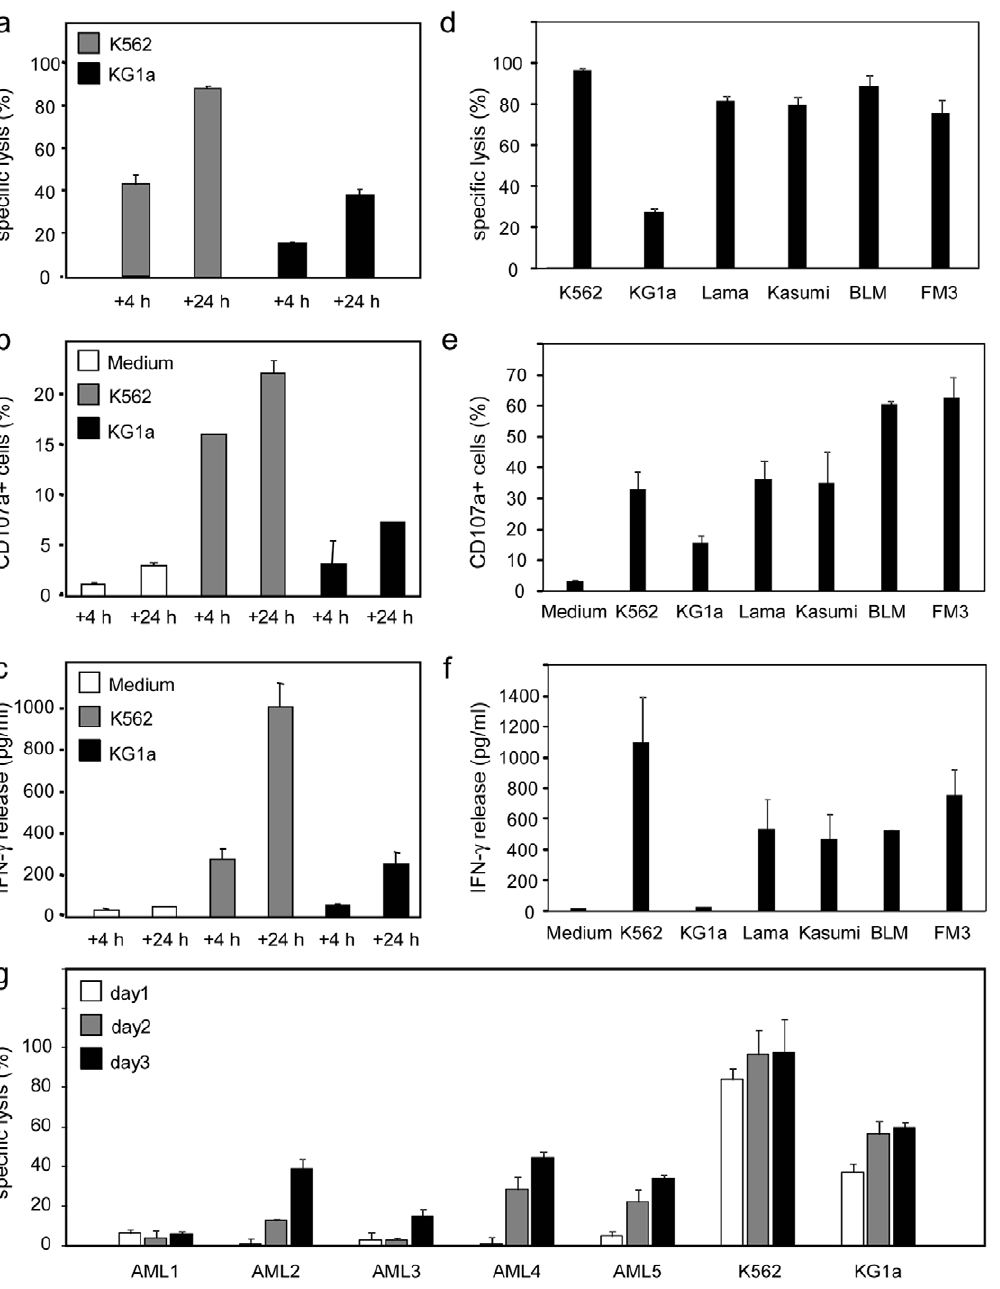
Figure 6. Functional activity of exvivo -generated CD56 + NK cells using Method II with GBGM. ( a ) Specific cytotoxicity of a CD56 + NK cell product (98% purity) against the myeloid leukemia cell lines K562 and KG1a. Specific lysis was determined after 4 and 24 hours of co-culture in a FCM-based cytotoxicity assay at an E:T ratio of 2:1. Data are displayed as mean 6 SD of triplicate wells. ( b ) Degranulation of CD56 + NK cells was determined by FCM as the percentage of CD107a + cells. Results are depicted as mean 6 SD of triplicate wells. ( c ) IFN c production was determined by ELISA and depicted as mean 6 SD of triplicate measurements. ( d ) Specific cytotoxicity of another CD56 + NK cell product (95% purity) against the myeloid leukemia cell lines K562, Lama, Kasumi and KG1a, and the melanoma cell lines BLM and FM3. Specific lysis was determined after 18 hours of co-culture in a FCM-based cytotoxicity assay at an E:T ratio of 1:1. Data are displayed as mean 6 SD of triplicate samples. ( e ) Degranulation of CD56 + NK cells was determined by FCM as the percentage of CD107a + cells after overnight stimulation with different targets. Data are depicted as mean 6 SD of triplicate samples. ( f ) IFN c production was determined by ELISA and depicted as mean 6 SD of triplicate measurements. ( g ) Specific cytotoxicity of a third CD56 + NK cell product (97% purity) against primary AML cells from 5 different patients. Specific lysis was determined after 24, 48 and 72 hours of co-culture in a FCM-based cytotoxicity assay at an E:T ratio of 3:1. Data are displayed as mean 6 SD of triplicate samples. doi:10.1371/journal.pone.0009221.g006 purity of 40%–60% after 5–7 weeks of culture. They reached a of animal and human sera [15–17,20–24]. For instance, a recent calculated mean expansion rate of 300-fold, but used fetal bovine study by Kao et al. showed that serum-free expanded CD34 + cells could be differentiated into a NK cell product with an average serum during the NK cell generation phase [16]. Compared to